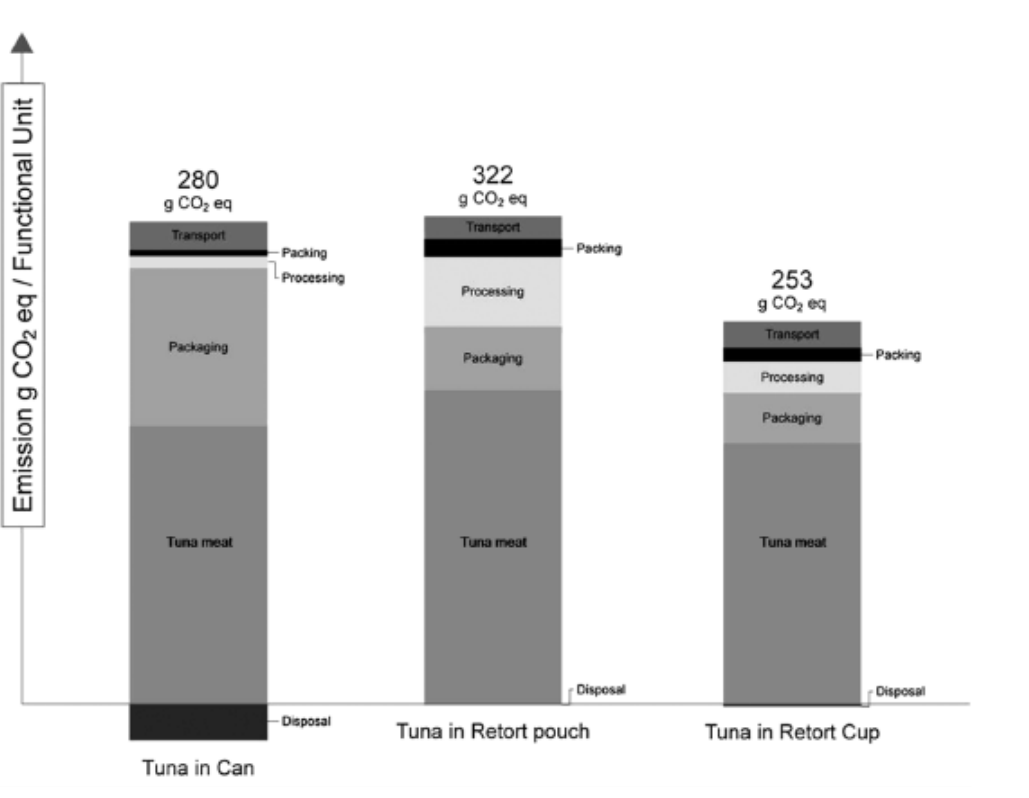
Figure 20: Life cycle greenhouse gas emissions related to different tuna products. Source: Poovarodom, Ponnak and Manatphrom.